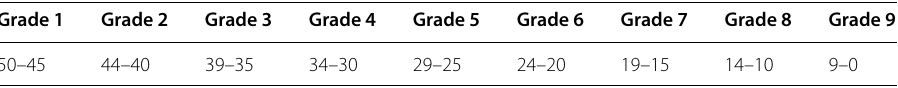
Table 3 Number of points per grade under absolute standard (total 50 points; Ministry of Education,